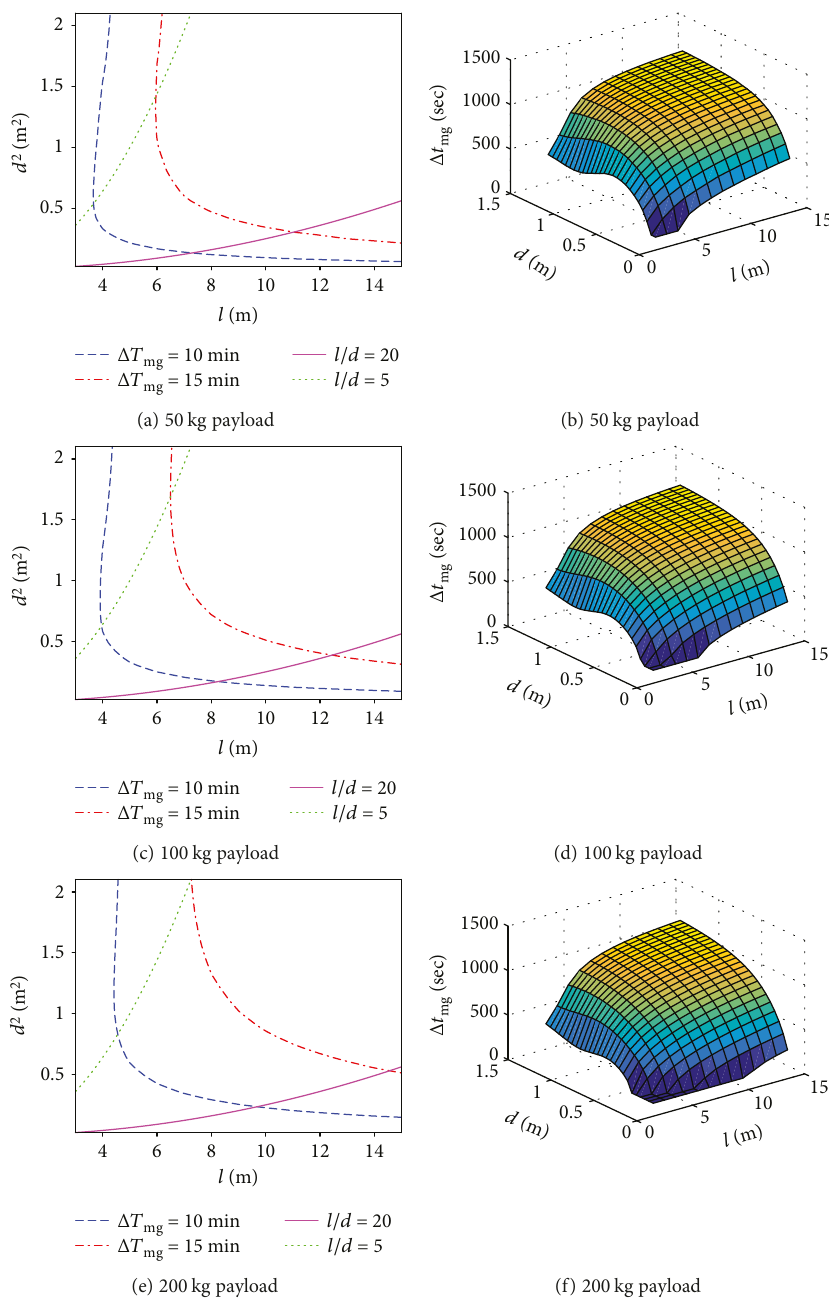
Figure 10: Optimal results for the near radial